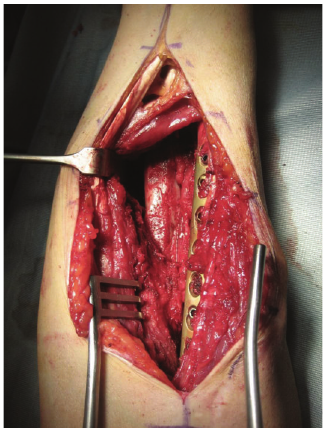
Figure 3: Complete removal of the synostosis.